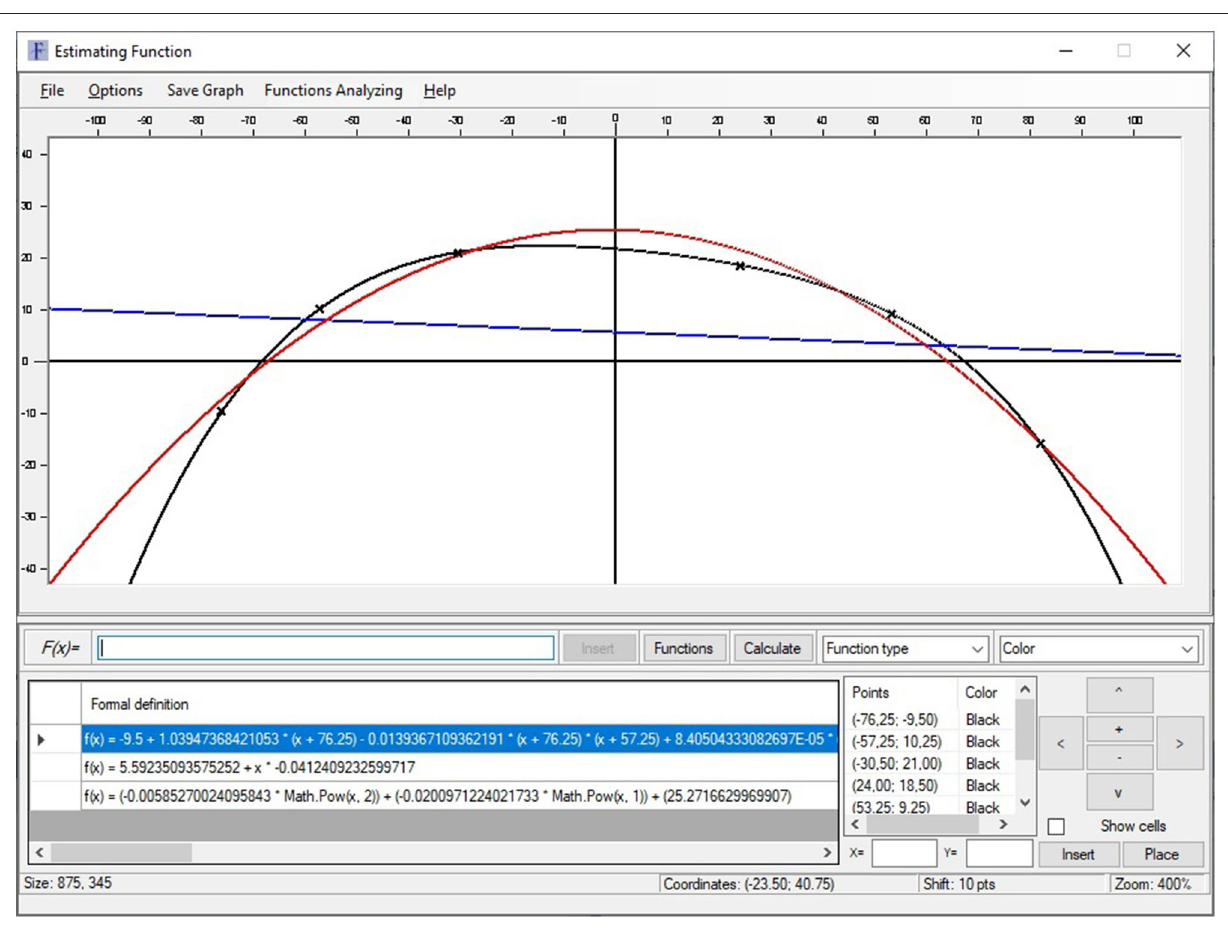
FIGURE 1 | Main application